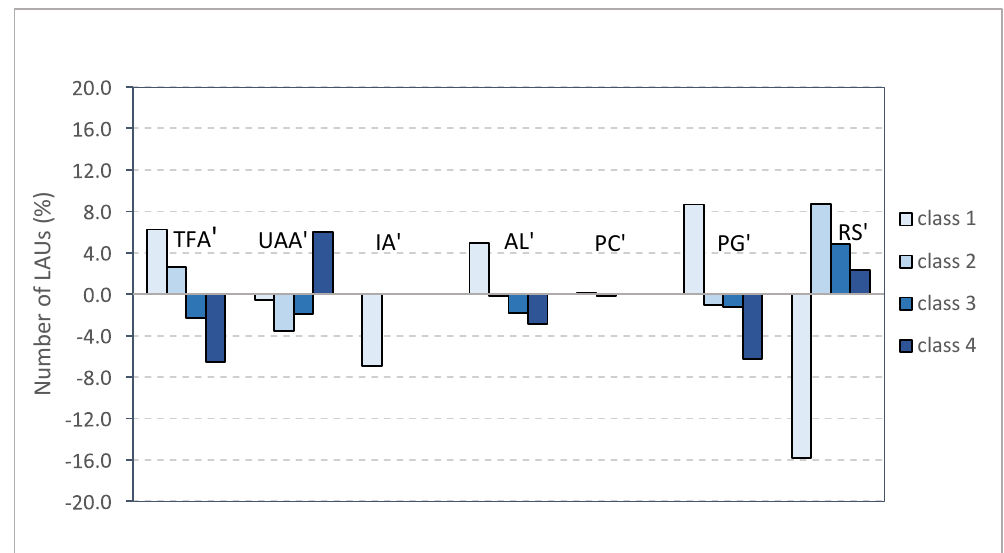
Figure 7. Difference in percentage of LAUs’ number between the values of the two census dates (C2 value ‒ C1 value).